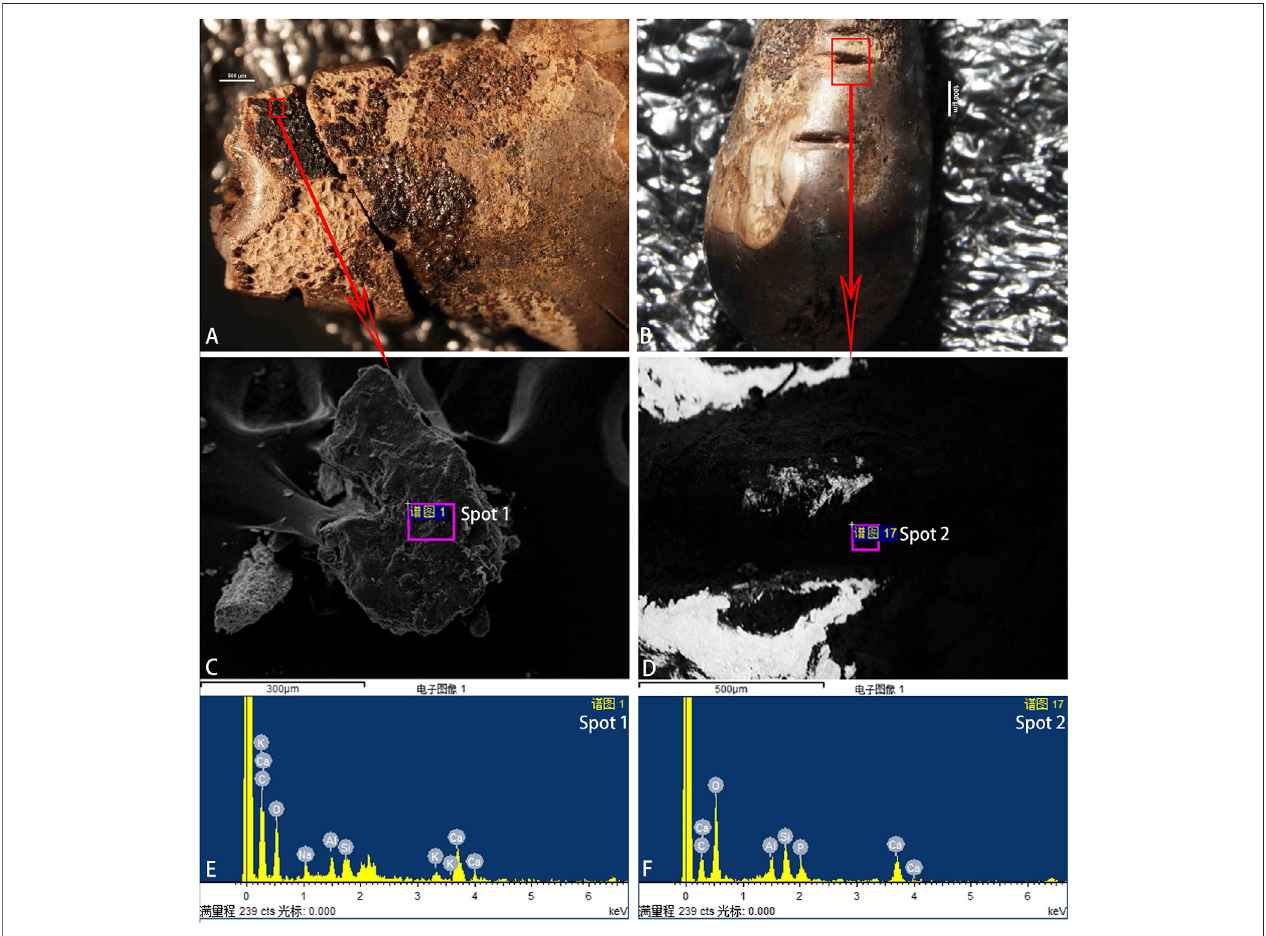
FIGURE 9 | (A,C) Area in which black residues were sampled under SEM; (B,D) Area in the background where comparative samples were analyzed under SEM- EDS; (E,F) SEM-EDS spectra showing the chemical composition of the sampled residues; Scales: (A,D) 500 μ m, (C) 300 μ m, (B) 1000 μ m.